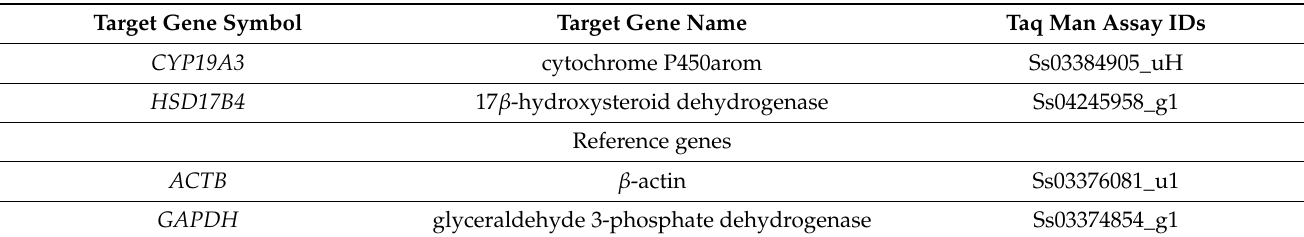
Table 4. Taq Man probes used for determination of cytochrome P450arom ( CYP19A3 ) and 17 β -hydroxysteroid dehydrogenase ( HSD17B4 ) mRNA transcript abundance in the myometrium of pigs during the peri-implantation period treated in vitro with an electromagnetic field at 50 and 120 Hz for 2 and 4 h in the presence or absence of P 4 . Target Gene